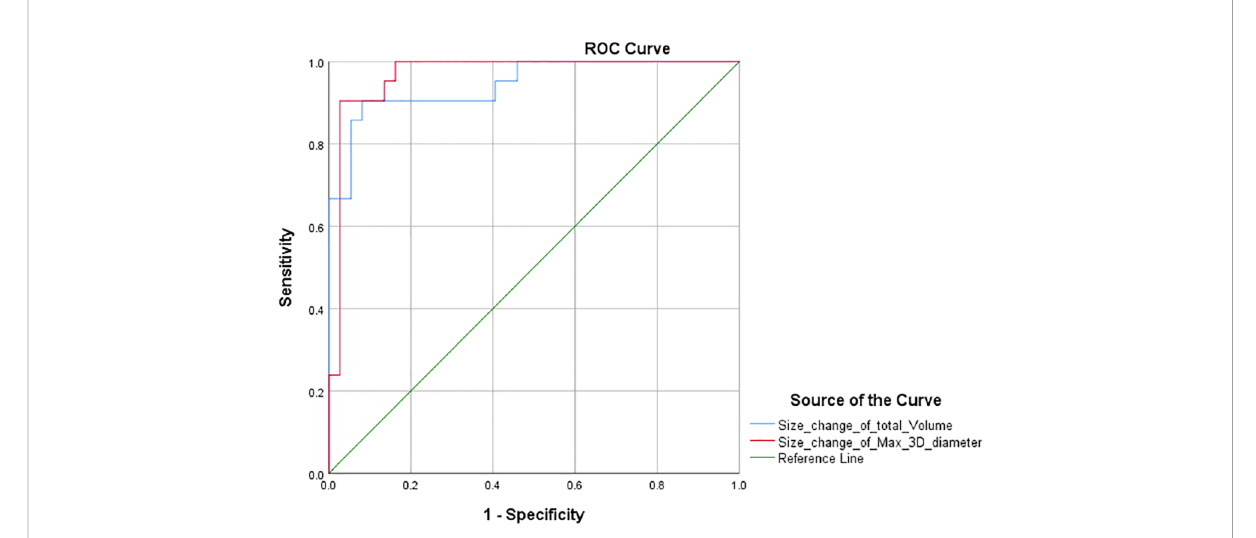
FIGURE 4 ROC curve with PD threshold as variable.